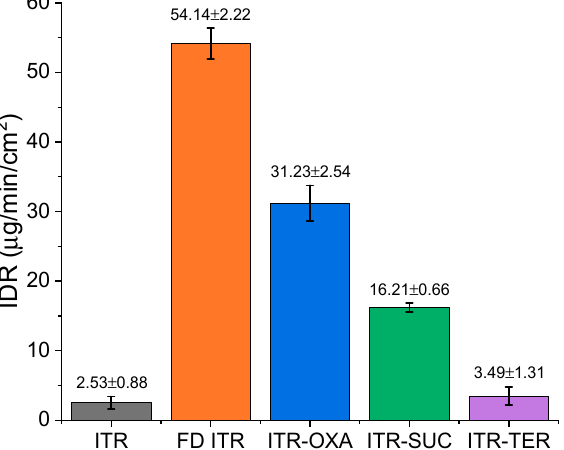
Figure 11. Intrinsic dissolution rates (IDRs) of: ITR starting material powder (ITR), freeze dried ITR (FD ITR), the ITR–OXA cocrystal, ITR–SUC cocrystal and ITR–TER cocrystal.